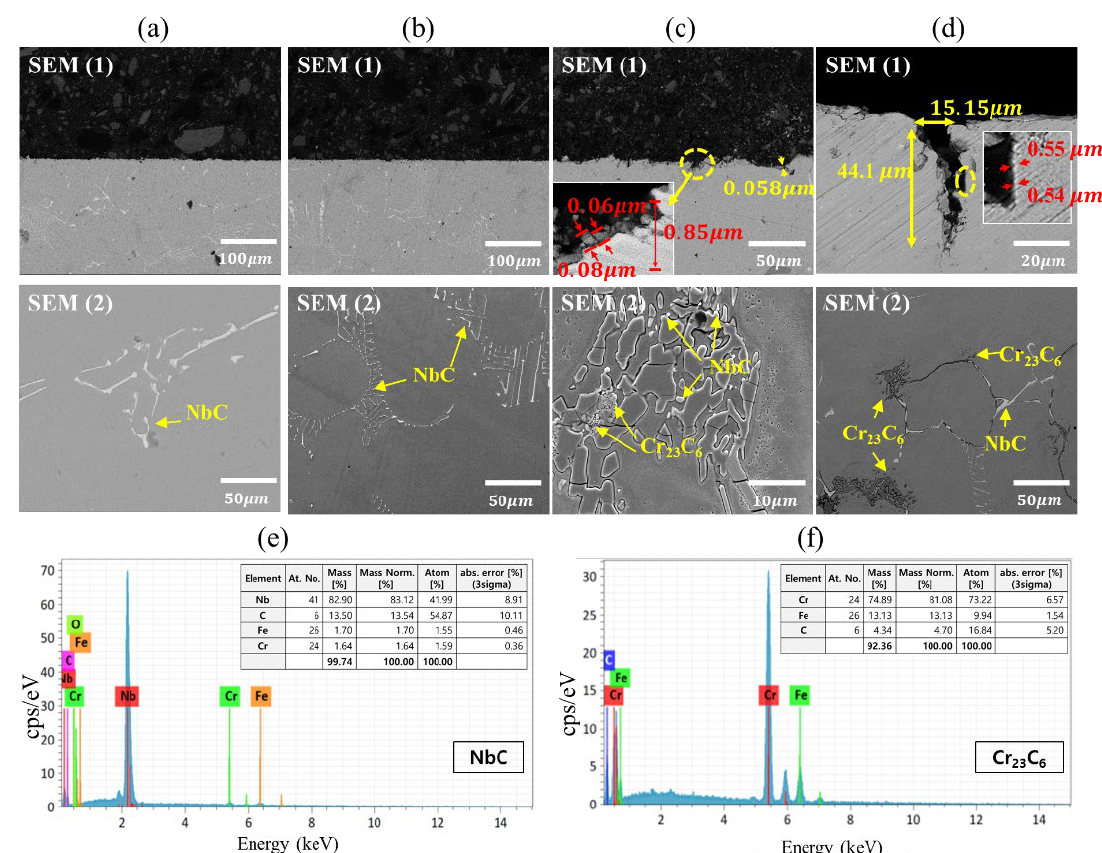
Figure 6. SEM-back scattered electron image of oxidation damage (SEM 1) and carbide precipitation (SEM 2) after the 0.5% strain amplitude LCF tests at ( a ) 200 °C; ( b ) 400 °C; ( c ) 600 °C; ( d ) 800 °C and EDS analysis of carbide precipitation of ( e ) NbC; ( f ) Cr 23 C 6.